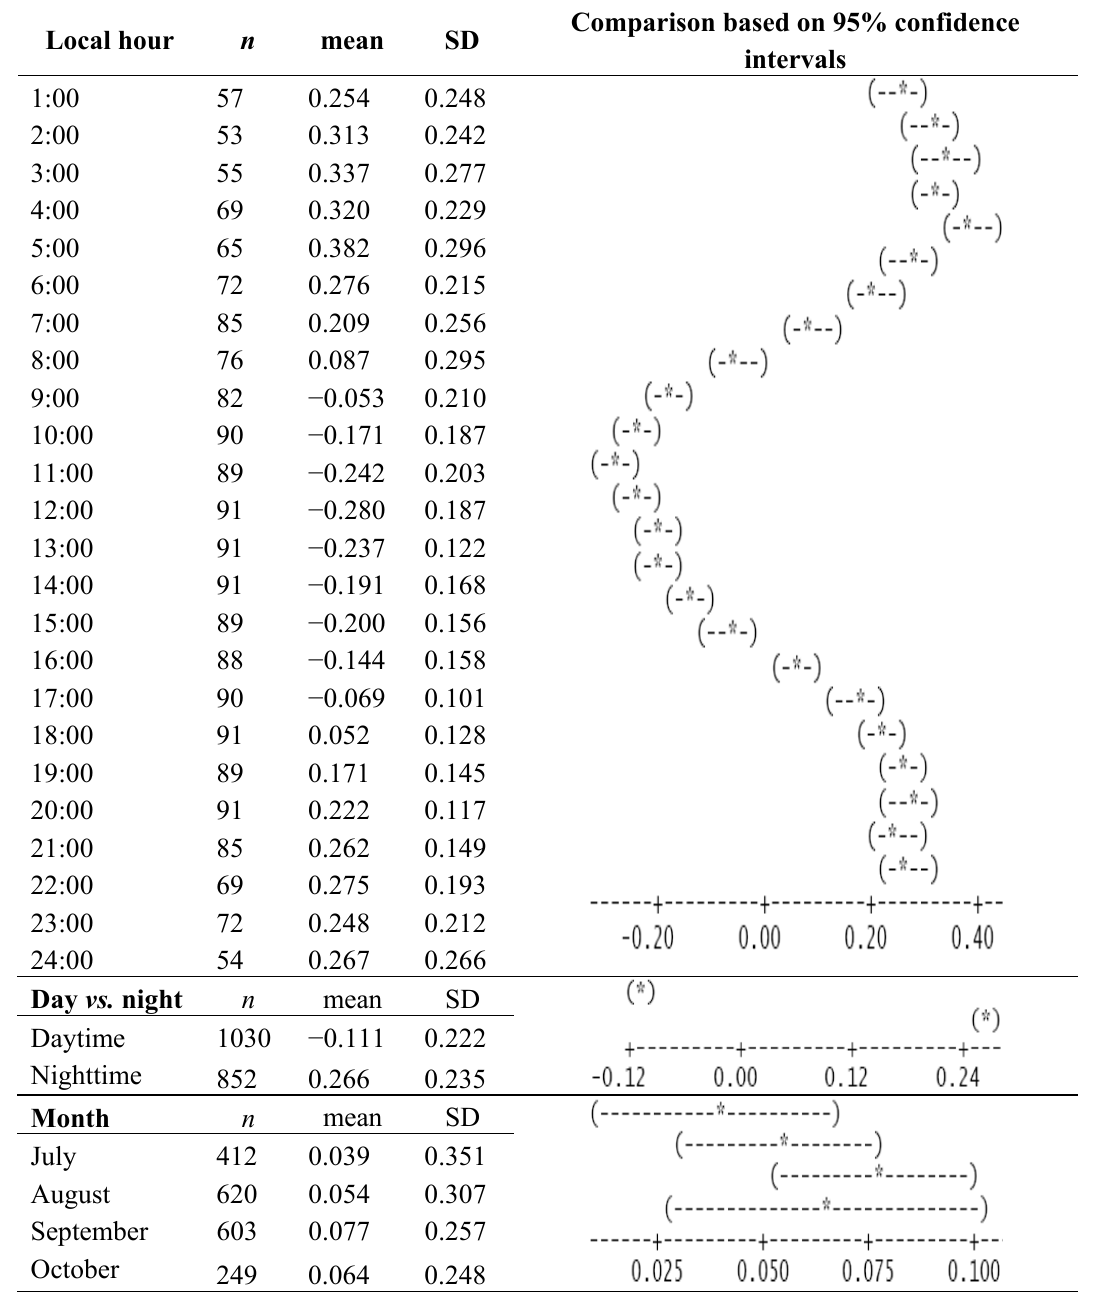
Table 2. A multiple comparison of mean F peatland by different temporal scales ( P < 0.001).